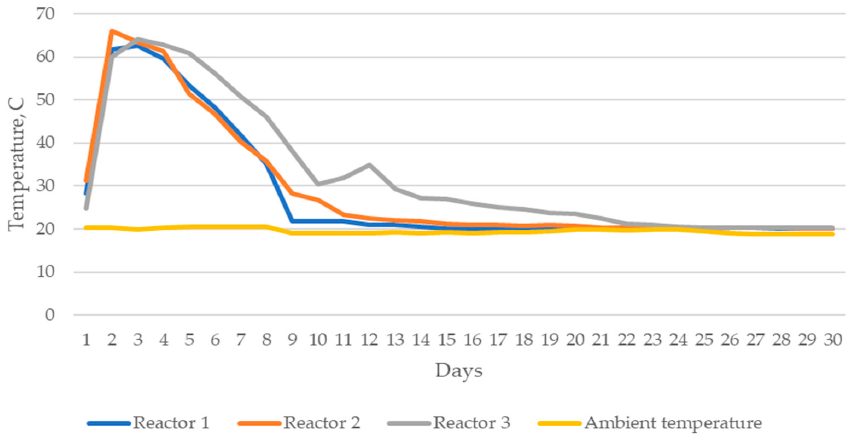
Figure 2. Temperature evolution in the composting reactors R1, R2 and R3 was recorded for a period of 4 weeks.